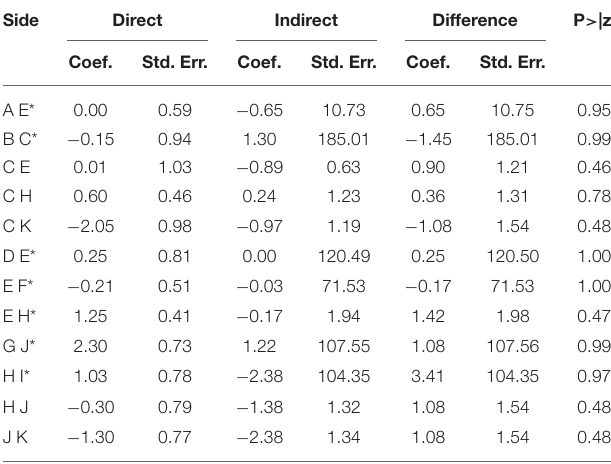
TABLE 8 | Node–splitting test for inconsistency of network meta–analysis (postoperative 12h). Side Direct